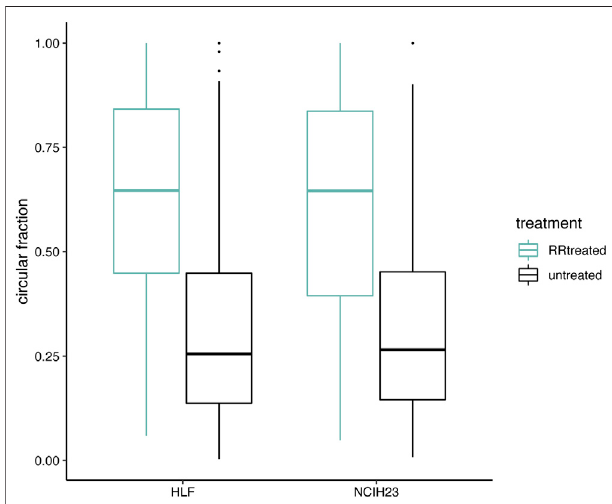
FIGURE 4 | Circular transcript fractions increase after RNase R treatment. Circular fractions at back-splice level, based on fl anking linear only junctions, are shown for back-splice junctions that were picked up ( ≥ 6 reads) inbothconditionswithinonecellline(406uniqueback-splicejunctionsin total; 305 in HLF and 223 in NCIH23). Pairwise comparisons within a cell line show a signi fi cant difference before (black) and after (green) RNase R treatment (Wilcoxon signed-rank test; p <